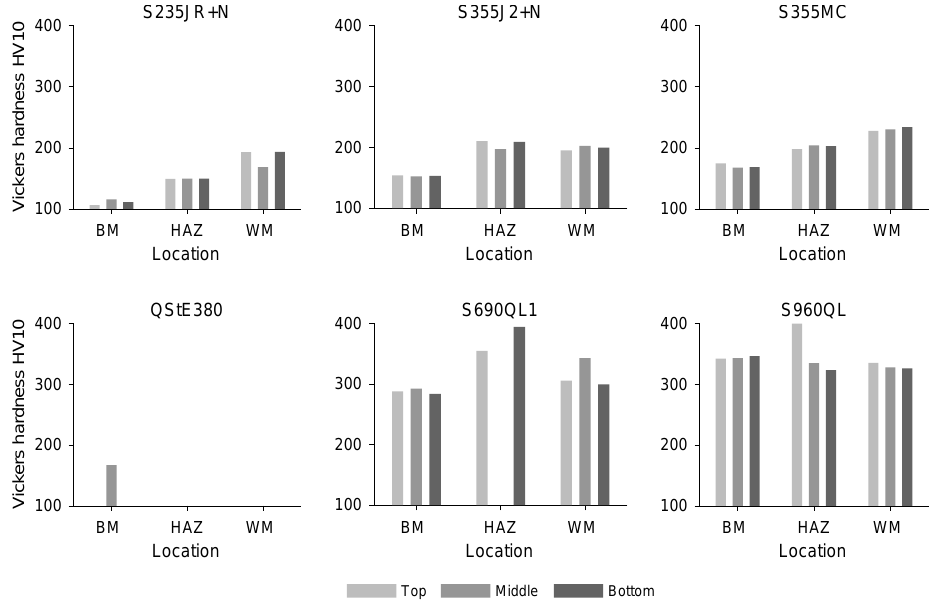
Figure 2. Hardness measurements for the six steel grades with results for the different zones and layers of the welded plates according to ISO 6507-1:2005, data from